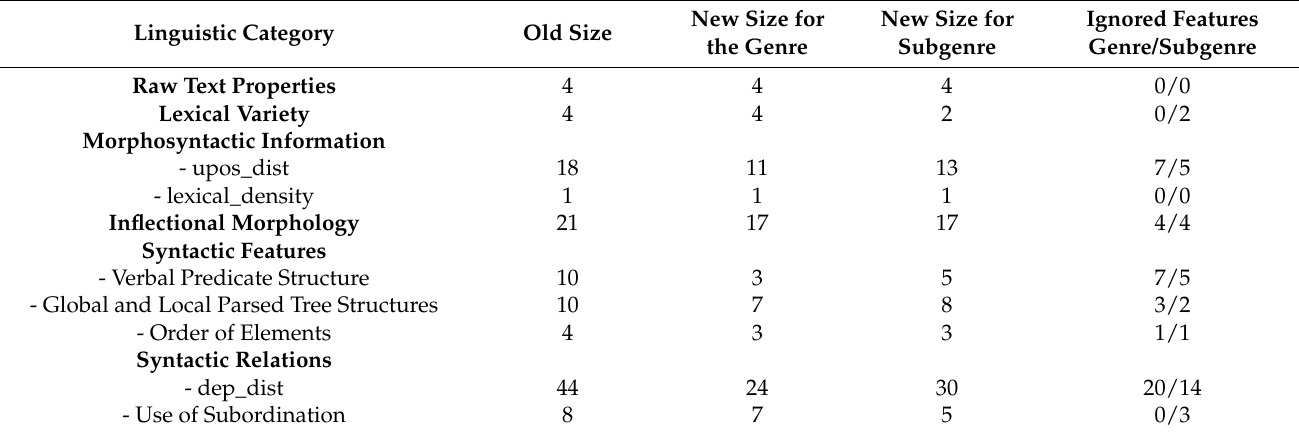
Table 6. Feature details after dimensionality